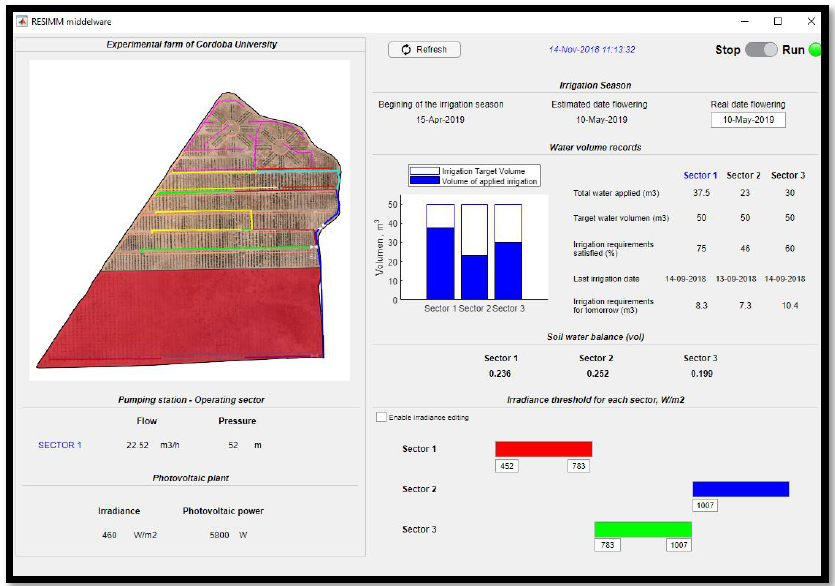
Figure 4. RESSIM graphical user interface (GUI).